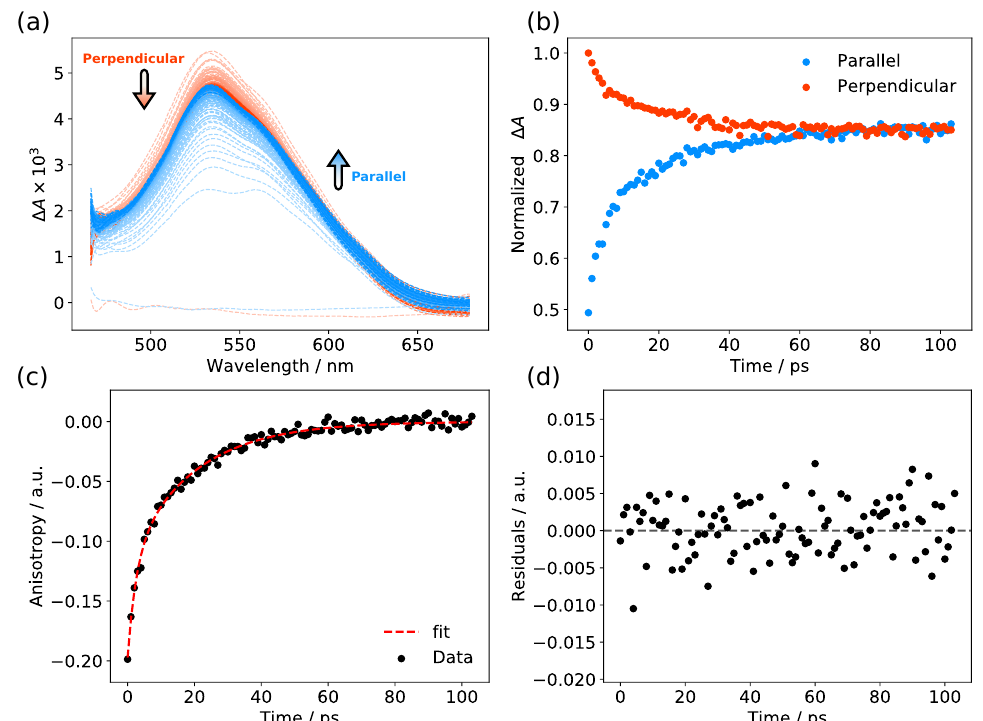
Figure 3. Picosecond time-resolved absorption and anisotropy of ClC 16 in DCM. ( a ) ps time-resolved absorption of ClC 16 in DCM measured with parallel and perpendicular relative polarization of the pump and probe. ( b ) The difference absorption integrated over the absorption band ( Σ∆ A ) vs delay time a parallel and perpendicular pump/probe configuration. ( c ) The decay of the anisotropy fitted to a single exponential decay. ( d ) Residuals of the fit.